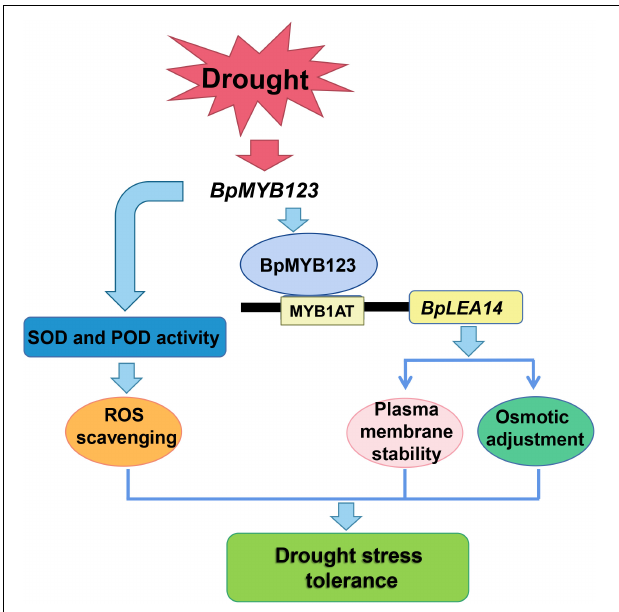
FIGURE 6 | Working model of BpMYB123 in response to drought stress.